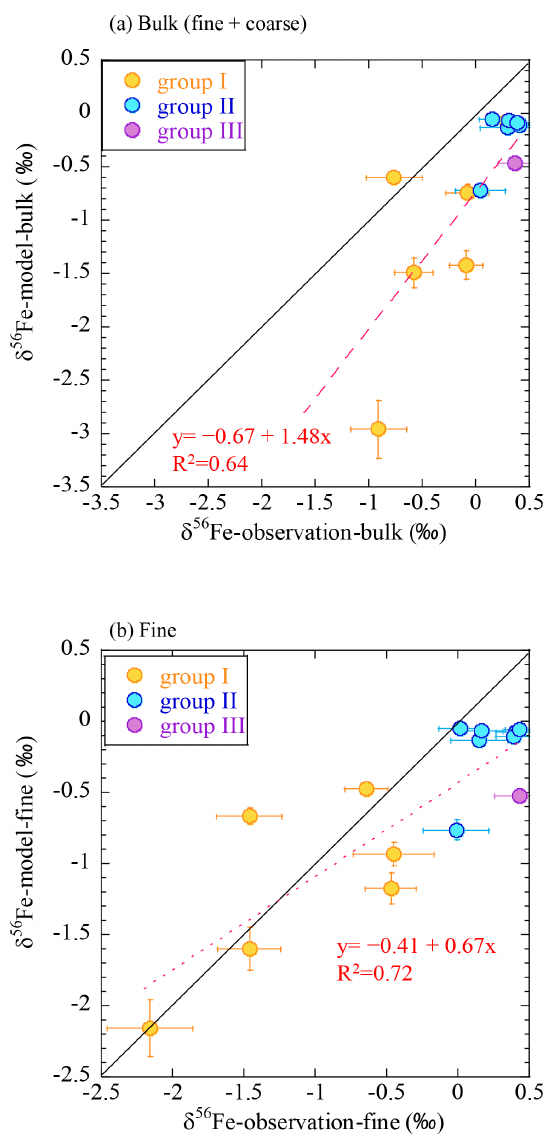
Figure 10. Comparison of the δ 56 Fe values by observation with the IMPACT model prediction for (a) bulk (fine + coarse) and (b) fine particles. Yellow, group I; blue, group II; purple, group